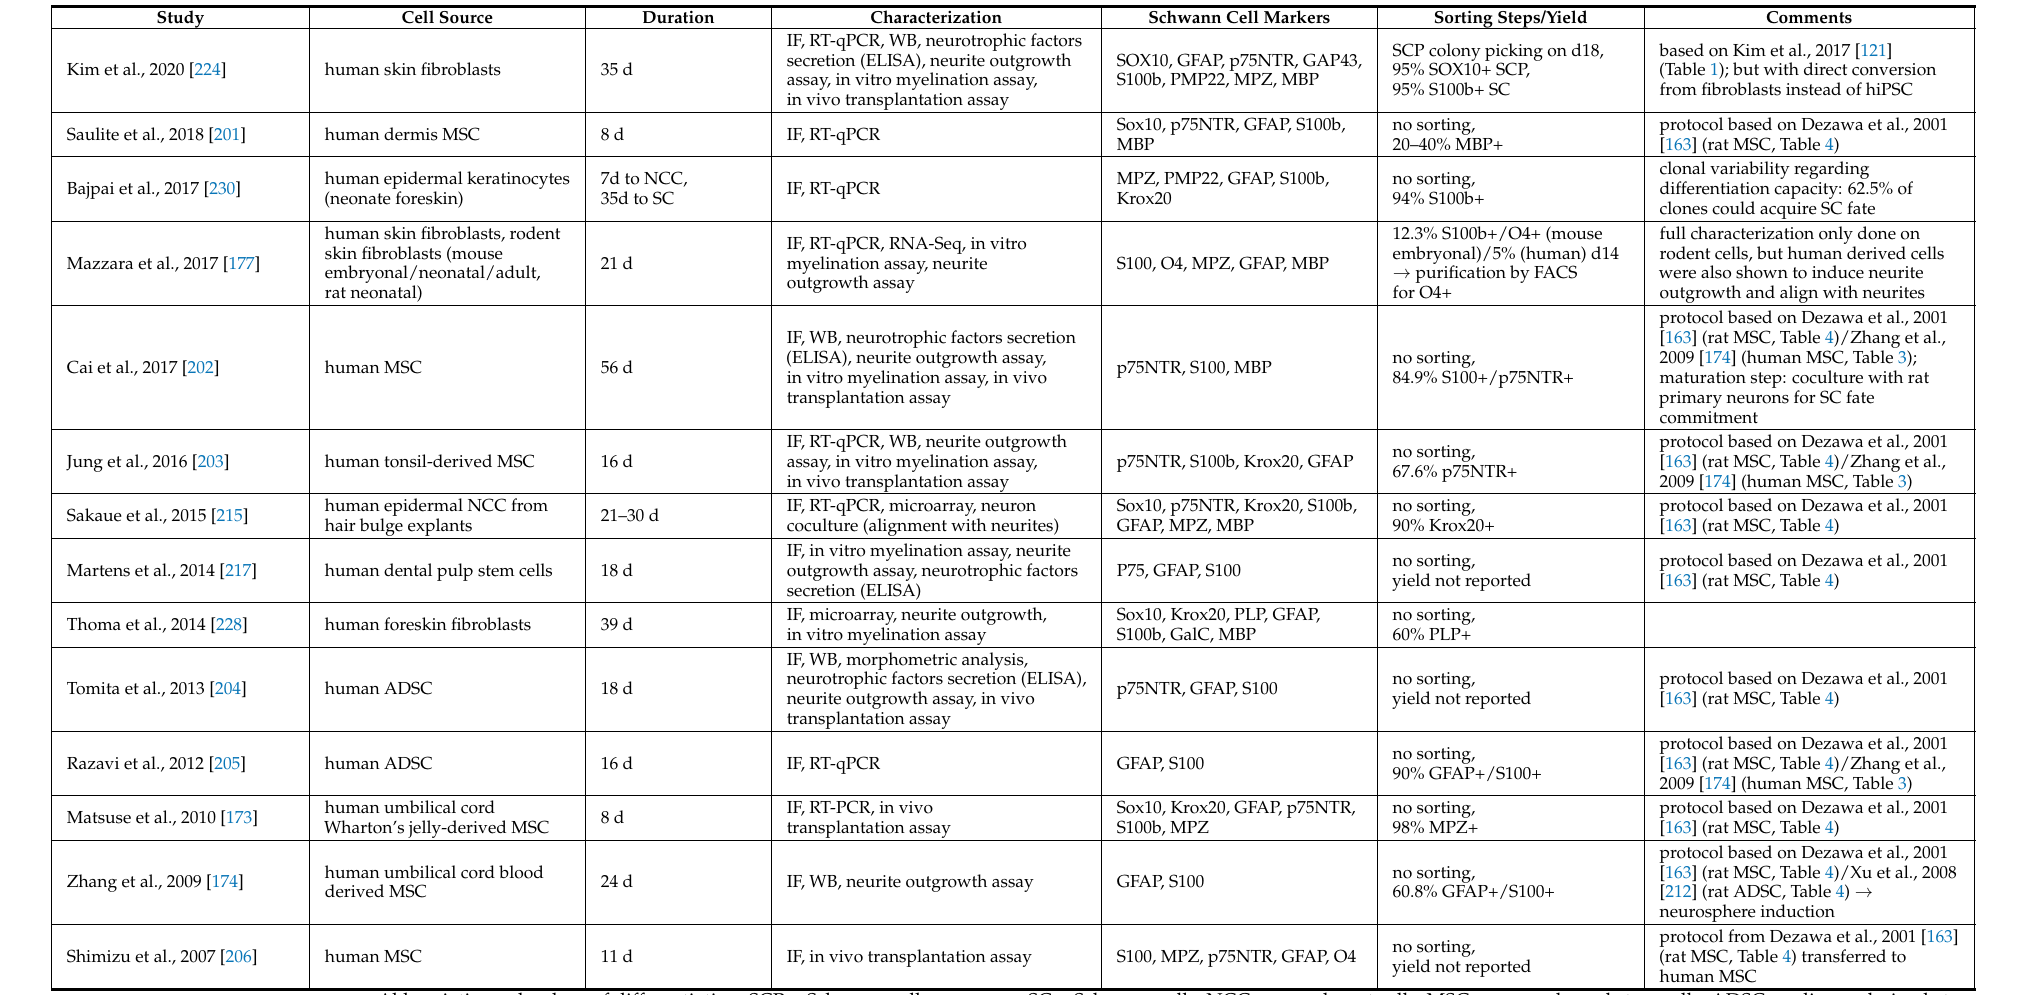
Table 3. Studies describing differentiation of Schwann cells from human cell sources other than hiPSC or hESC. Sorted from most to least